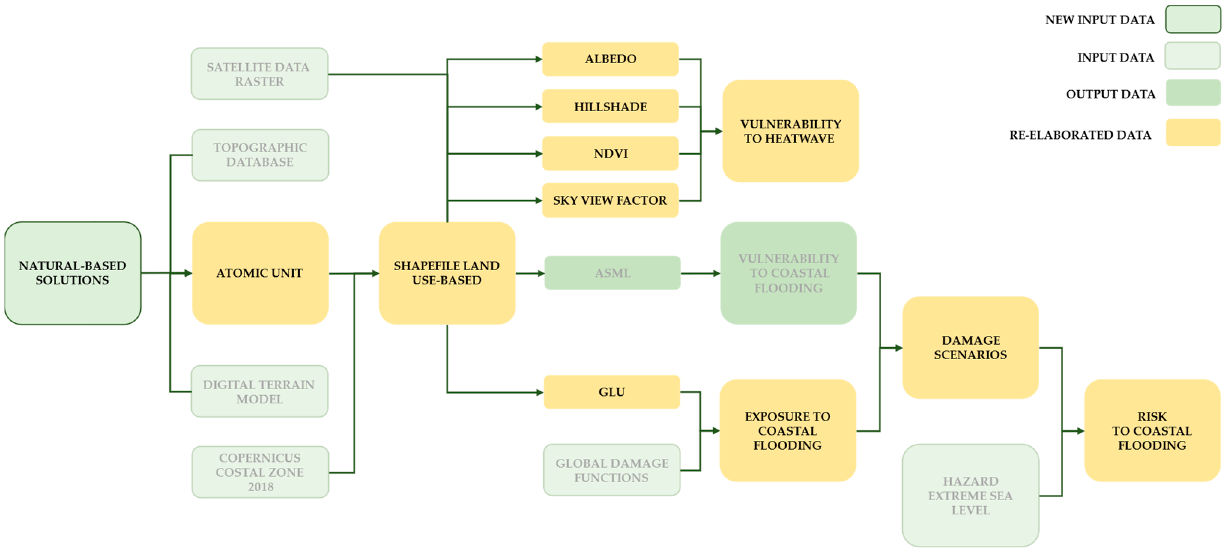
Figure 10. Workflow of the framework with the integration of NBSs.